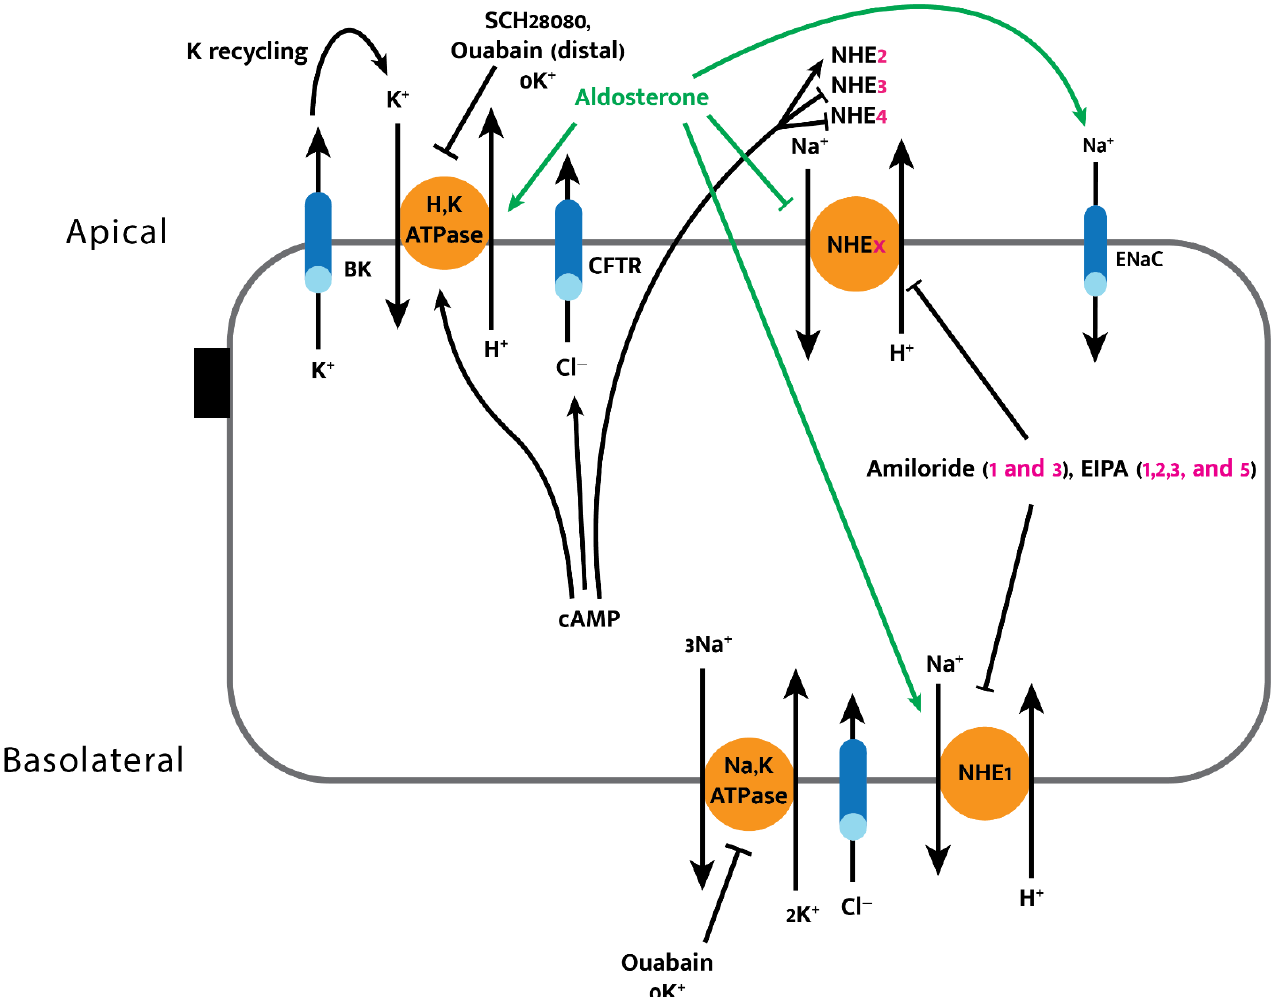
Figure 3. Hormone- and cAMP-mediated regulation of colonic electrolyte movement. Aldosterone inhibits apical NHE isoforms while activating H,KATPase, ENaC, and basolateral NHE1 in the distal colon; cAMP activates H,KATPase and NHE2 while inhibiting NHE3 and 4. The specific NHE isoforms modulated by amiloride and its analog EIPA are listed in parentheses. Ouabain exhibits an inhibitory effect on the Na,KATPase and on the apical H,KATPase in the distal colon. The NHE1 and NHE3 isoforms are inhibited by amiloride with varying inhibitory potencies (IC 50 = 5.3 and 100–309 µ M, respectively, for rat NHE1 and -3) via amiloride exposure [48]. Furthermore, the amiloride derivative ethylisopropylamiloride (EIPA) can inhibit NHE1, -2, -3, and -5 (ordered by increasing inhibitor binding affinity) at small concentrations [48]. The recently characterized NHE4 isoform, however, is characteristically resistant to amiloride and EIPA, making selective inhibition an easy way to specifically study NHE4 activity [44,48]. The perfusion of isolated human and rat colonic crypts loaded with pH-sensitive fluorescent dye (BCECF) allows for real-time intracellular pH measurements that provide insights into sodium-dependent proton exchange during exposure to hormones, drugs, secondary messengers, and various extracellular ionic milieu [44]. These experiments have shown that NHE4, like NHE1, plays a role in pH and cell volume regulation in the human colonic crypt, and that this isoform, along with NHE3, is downregulated by cAMP while NHE1 and NHE2 are upregulated by cAMP exposure [44]. Aldosterone’s effects are exemplary of the complex multi -level feedback and parallel regulation of apical and basolateral compartments required to precisely modulate electrolyte levels. In the mature distal colon, aldosterone stimulates apical ENaC and